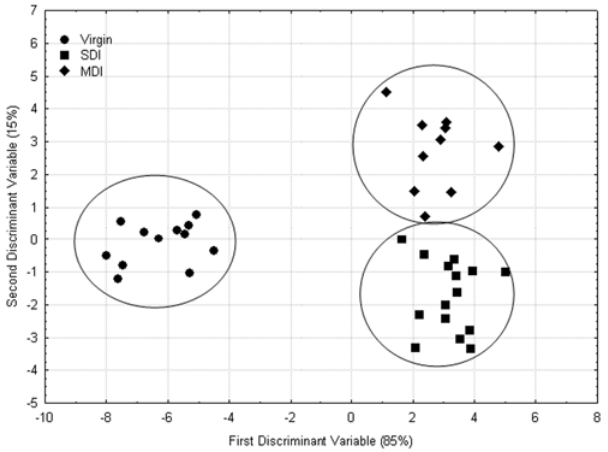
Figure 3. Insemination quantity significantly alters the chemical profile of mandibular glands. Chemical composition of the mandibular gland extracts of Virgin, SDI and MDI queens were analysed using gas- chromatography. Discriminant analysis of mandibular extract of virgin, SDI, and MDI queens was based on the relative proportion of the chemical compounds (F(33, 36)=9.33. p , 10 2 4 ; All group distances , 0.005). Ellipses have been drawn to emphasize the categories, but have no specific statistical